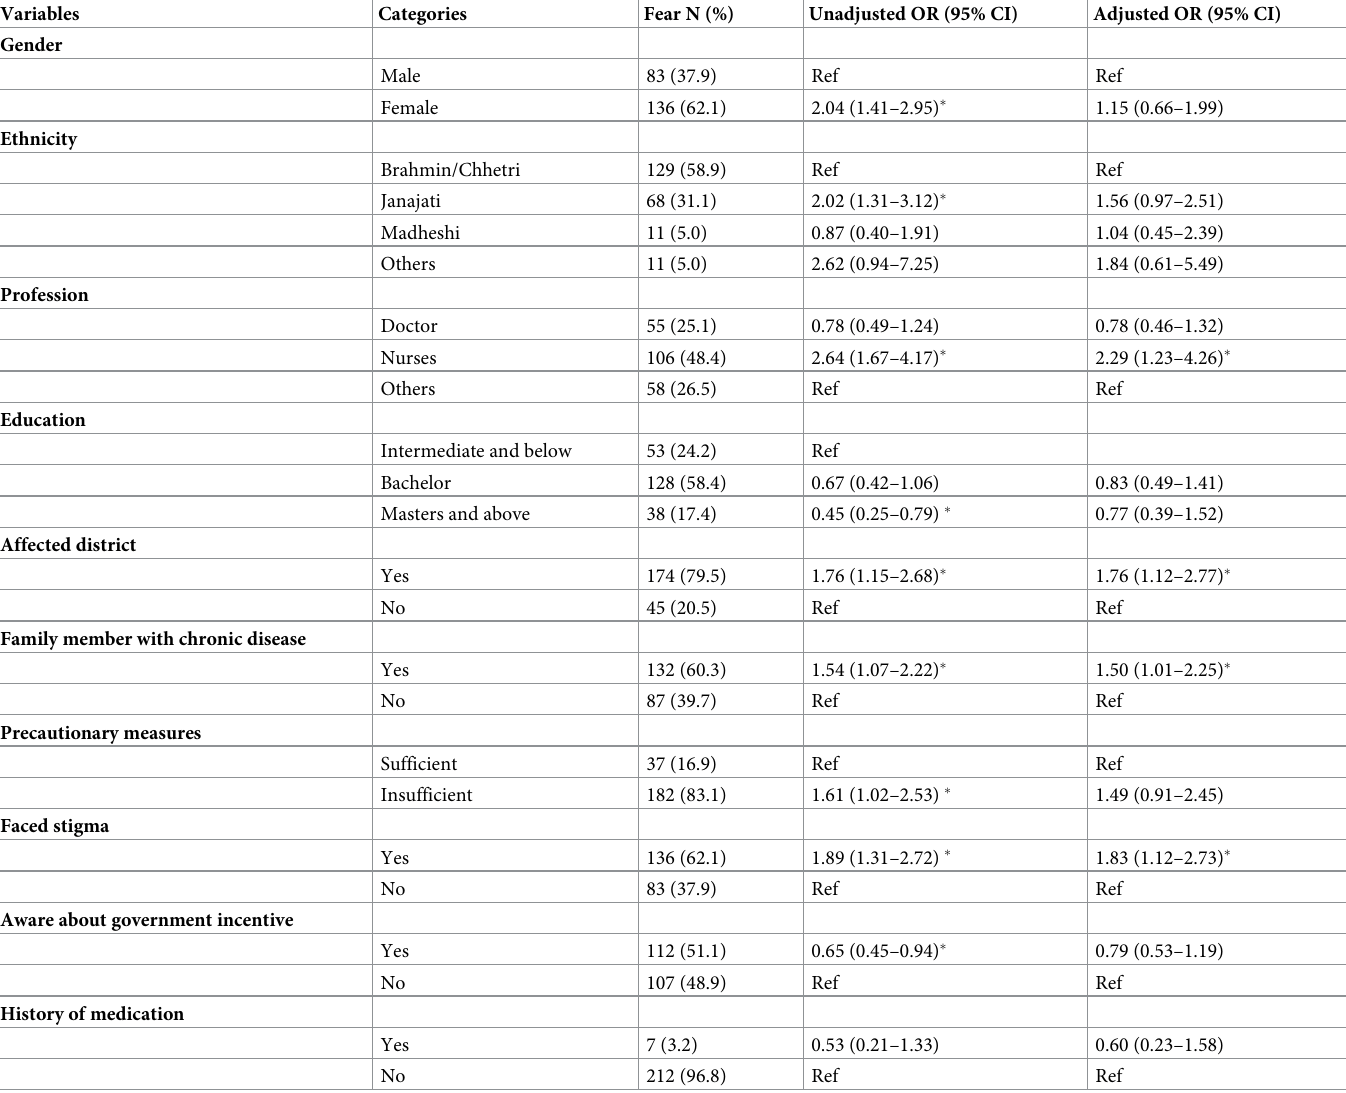
Table 3. Factors associated with COVID related fear among health workers (n =